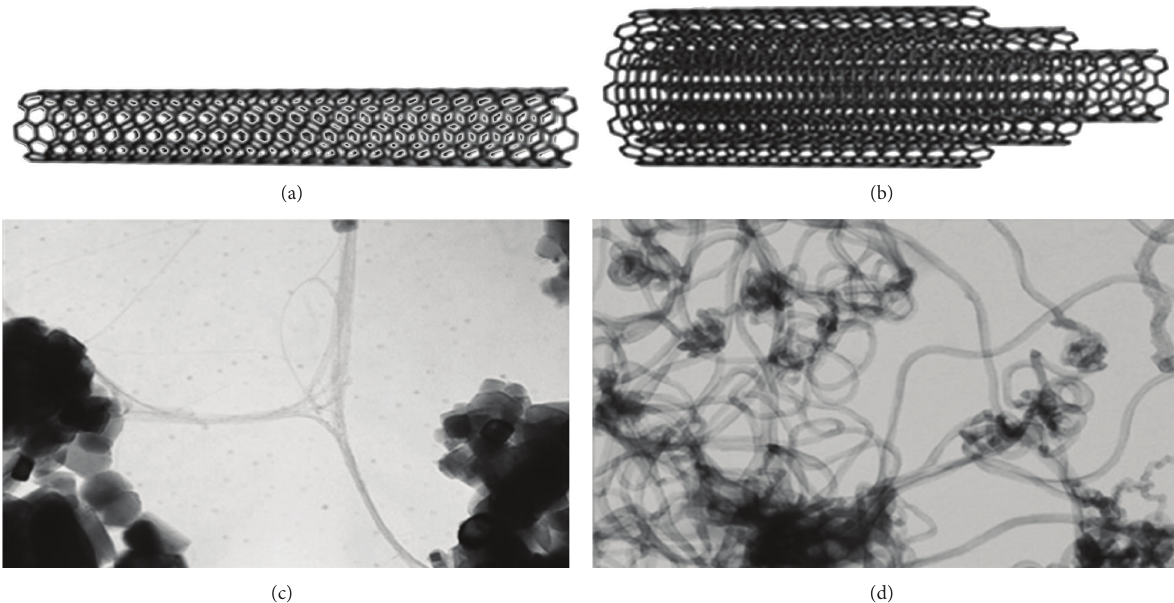
F 1: Molecular representations of SWCNT (top le) and MWCNT (top right) with typical transmission electron micrographs (below) [8]. T 1: Comparison between SWCNT and MWCNT. SWCNT MWCNT Single layer of graphene. Multiple layer of